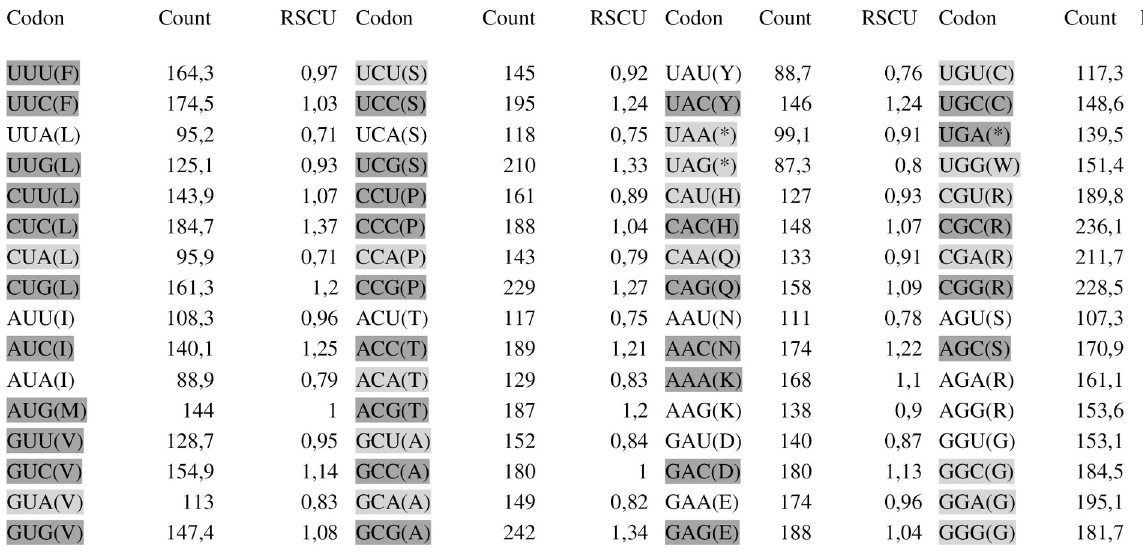
Fig 3. Relative synonymous codon usage (RSCU) for clinical FAdVs strain sequences. Darker shading indicates a higher RSCU value.